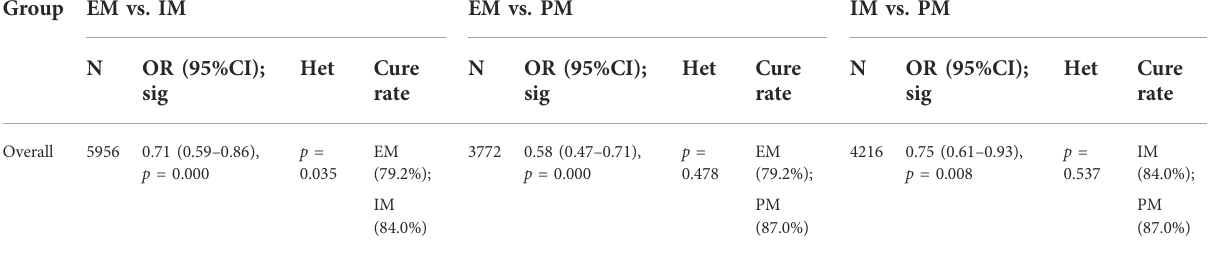
TABLE 3 Ef fi cacy of CYP2C19 polymorphisms on the overall cure rates of H. pylori . Group EM vs. IM EM vs. PM IM vs.